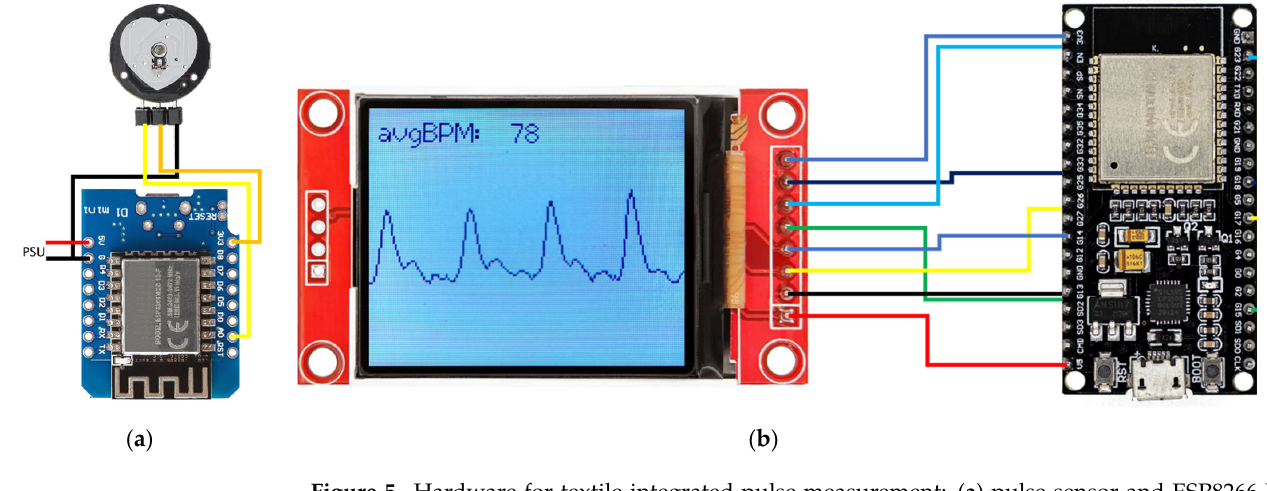
Figure 5. Hardware for textile-integrated pulse measurement: ( a ) pulse sensor and ESP8266 D1 mini to be embedded in the medical clothes, PSU = power supply unit; ( b ) ESP32 and 1.8 ″ display receiving and depicting the measured data outside the garment.